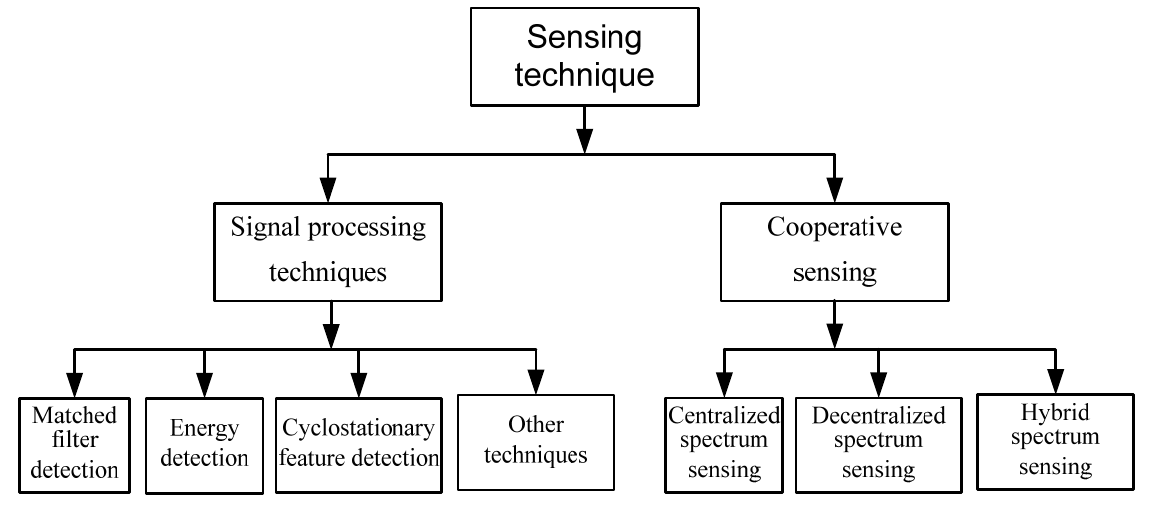
Figure 5. Classification of spectrum-sensing